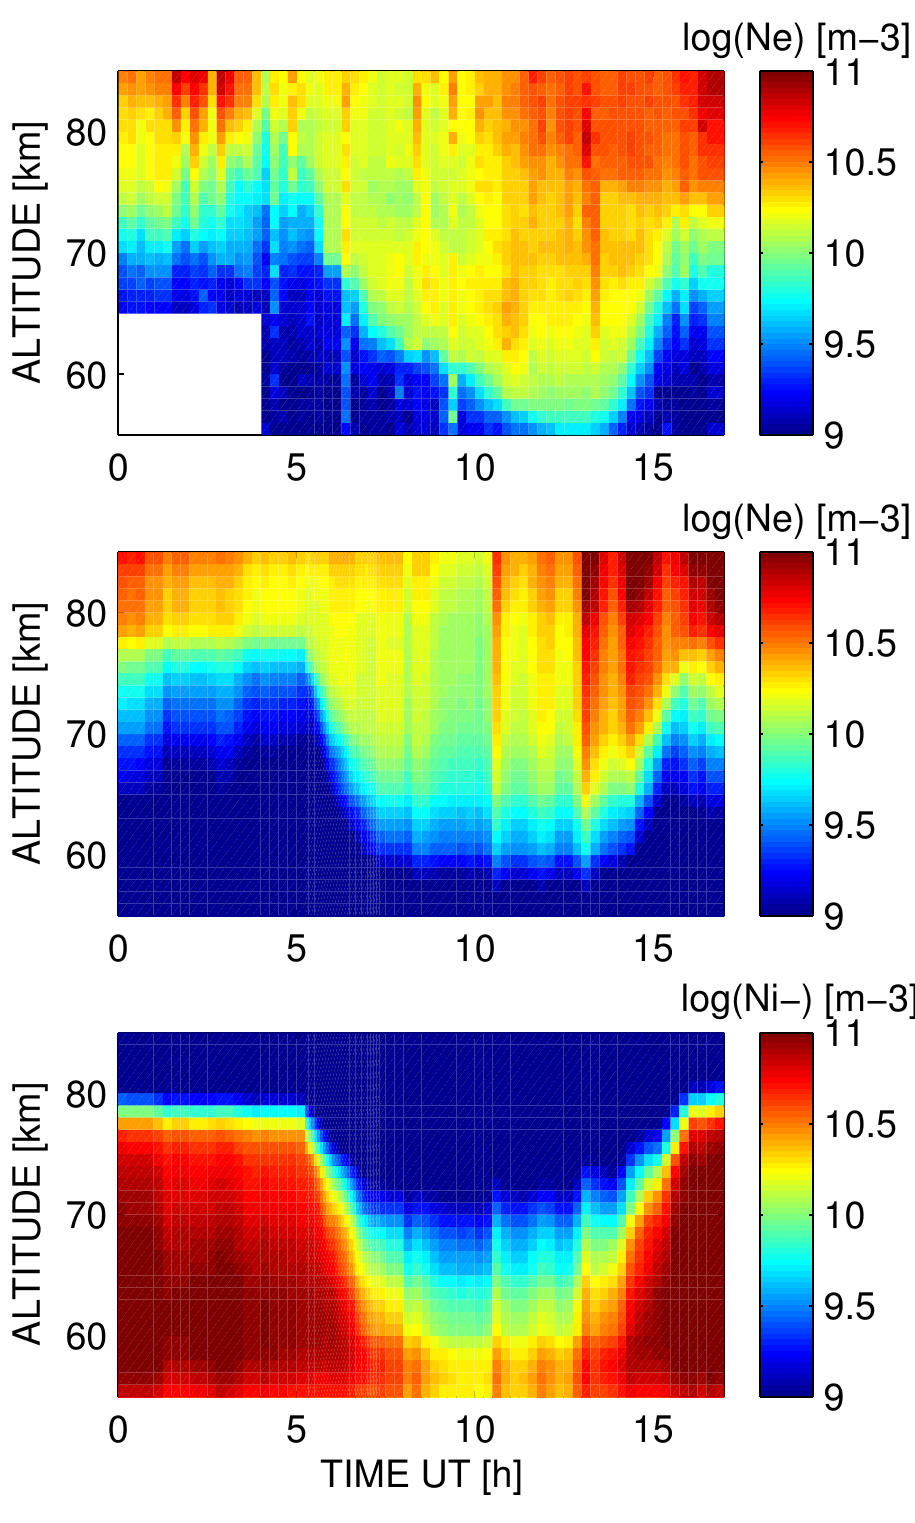
Fig. 3. Comparison of observations with model results: Electron density measured by the EISCAT VHF radar (the upper panel), modelled electron density (middle panel) and modelled negative ion density (bottom